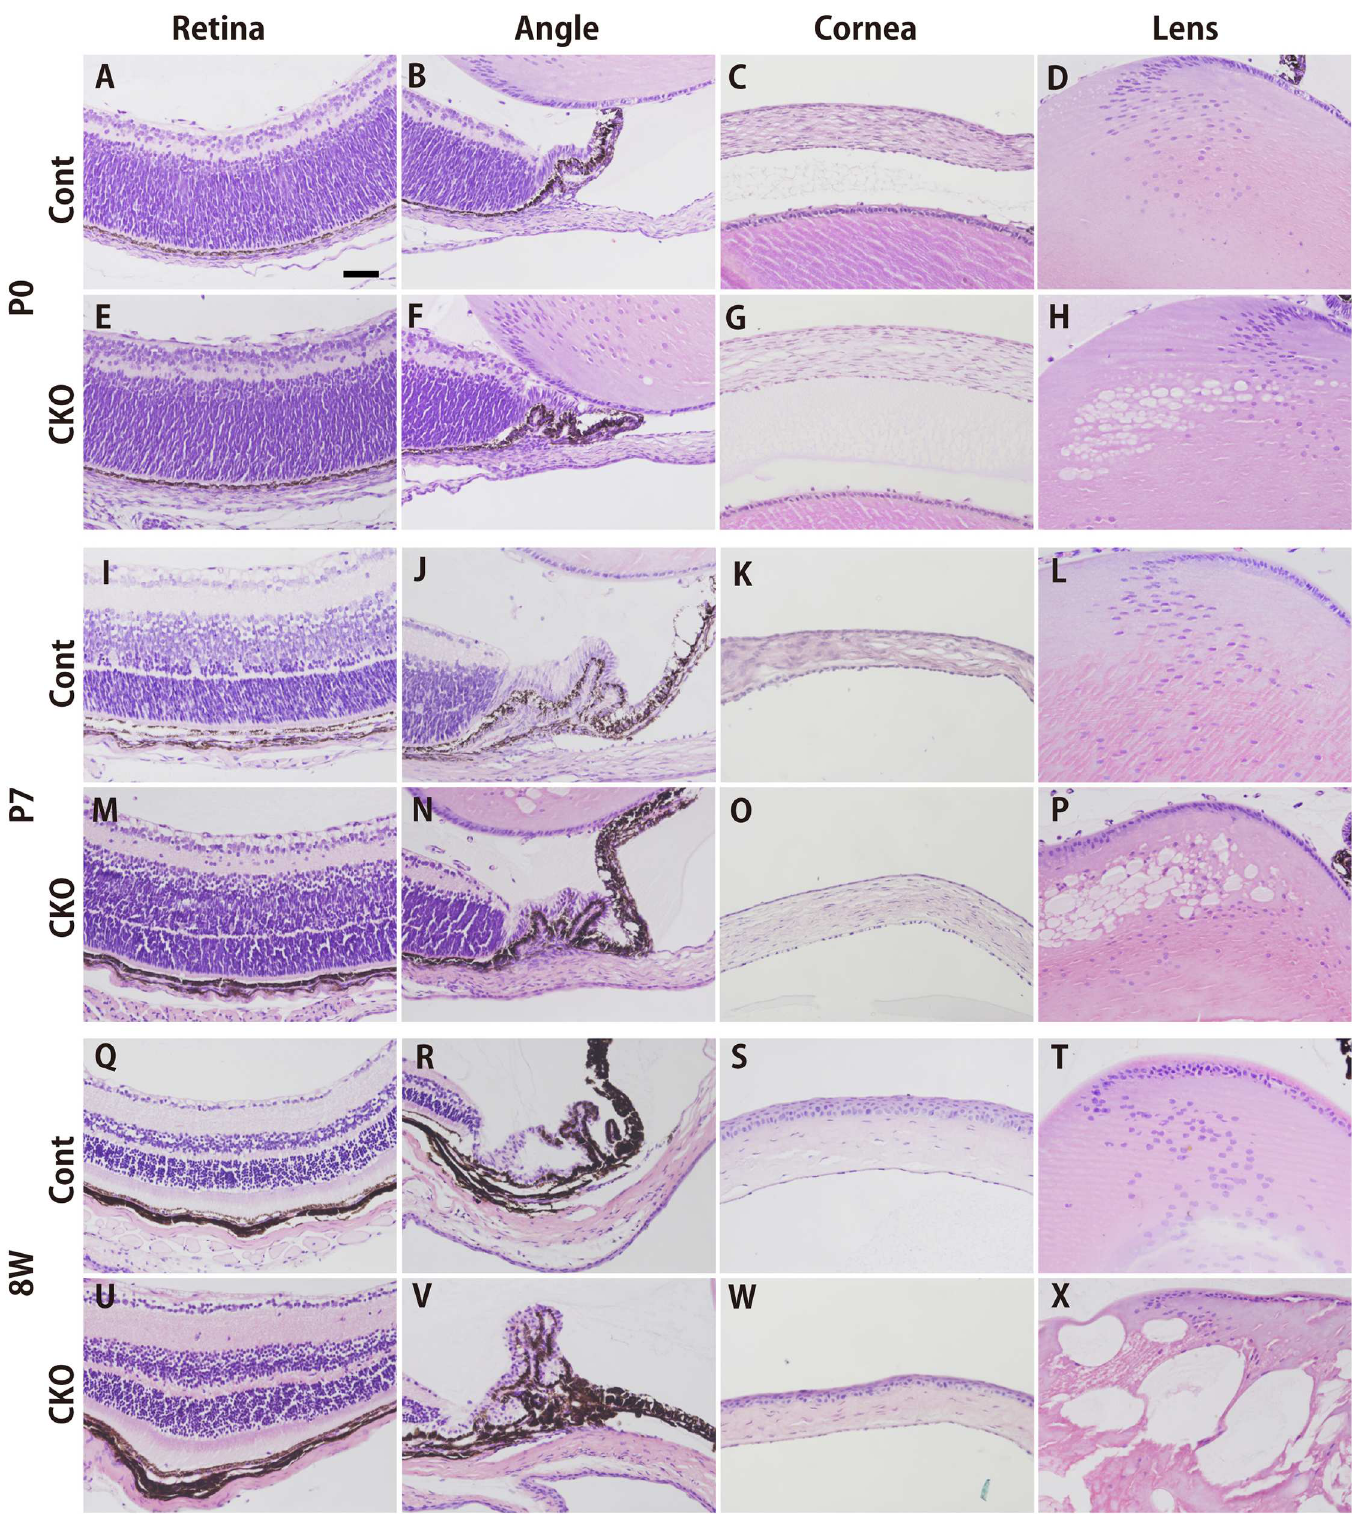
Fig 3. In vivo genetic ablationof Rest leadsto abnormallens differentiation. Oculartissues at P0 (A-H),P7 (I-P),and 8W (Q-X)in Rest CKO mice (E-H, M-P, U-X) and their controllittermates(A-D, I-L,Q-T).The retina(A, E, I, M, Q, U), angle (B, F, J, N, R, V), cornea(C, G, K, O, S, W), and lens (D, H, L, P, T, X) were shown. The scale bar represents50 μ